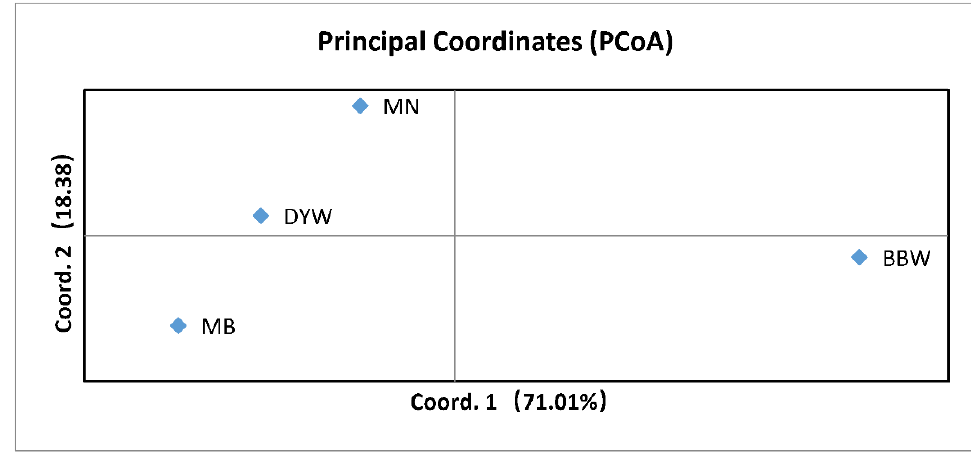
Figure 5. Clustering of individuals by structure at K = 2. Individuals are represented by vertical bars. Each vertical column represents one individual, and the separation of the column into two colors represents the estimated probability of belonging to one population or the other. Different colors in the same individual indicate the percentage of the genome shared with each cluster according to the admixture proportions. The y -axis represents the probability to belong to a certain cluster, while on the x -axis is reported each population (code name given in Table 1) delimited by a black solid vertical line.